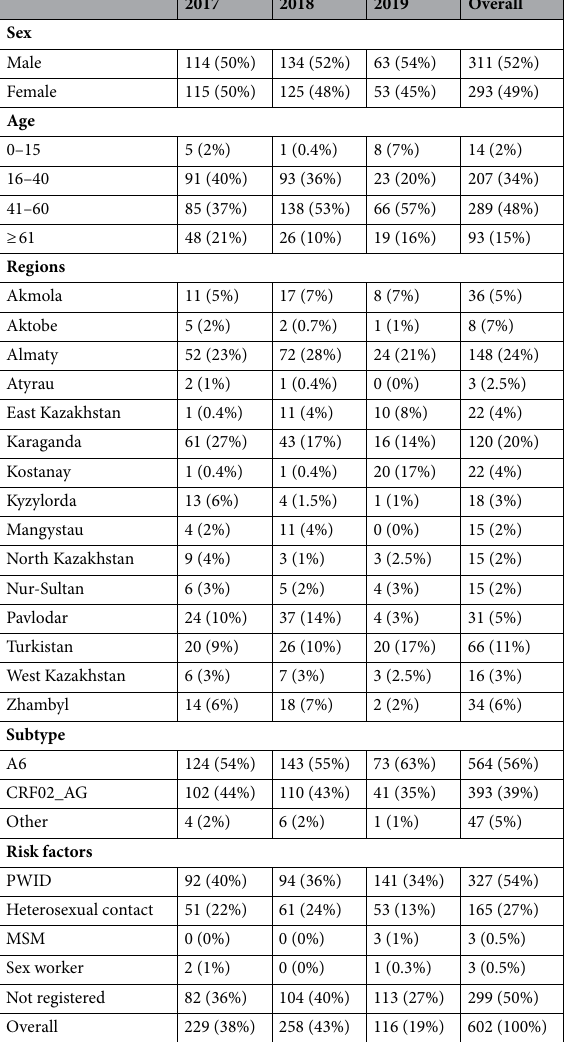
Table 1. Demographic information about study